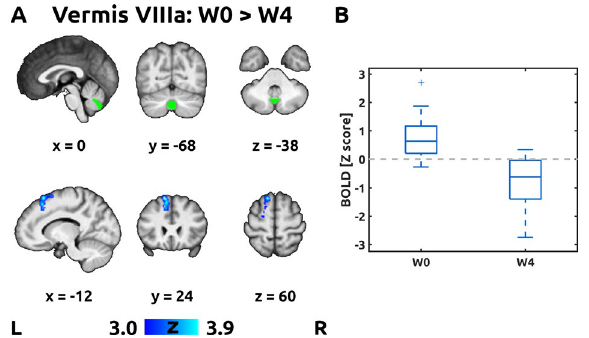
Figure 2. Pair-wise differences in connectivity. Panel A shows significant pair-wise changes in functional connectivity of the seed in the Vermis VIIIa between the baseline visit (W0) and the follow-up (W4), i.e., contrast W4 > W0. No other ROIs showed average changes in functional connectivity after BoNT-A treatment. The green overlay in the top row shows the region of interest in the cerebellum. The blue overlay in the bottom row shows the significant decrease in functional connectivity (positive connectivity turning to negative) in the left superior frontal gyrus, thresholded at Z > 3.0 and Bonferroni-corrected cluster significance level p < 0.00096. For remaining conventions, see Fig. 1. Panel B shows box plot of individual blood oxygen level-dependent (BOLD) response (Z score) averaged across the cluster in the left superior frontal gyrus from Panel